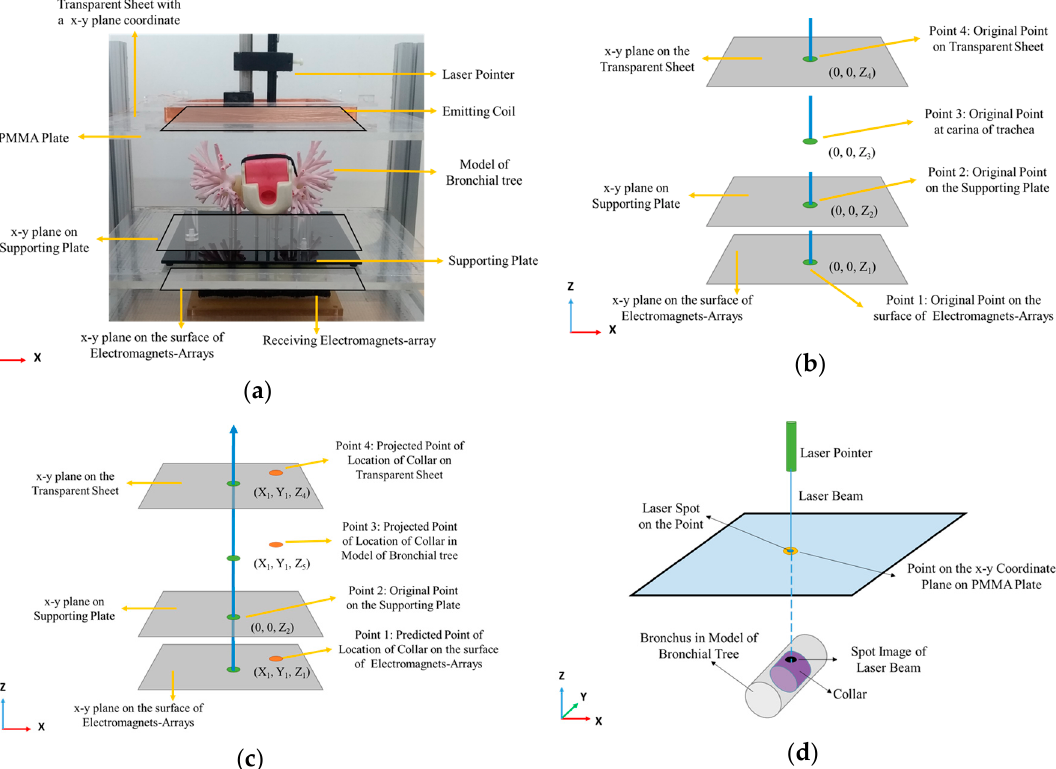
Figure 8. The photograph and illustration of the three parallel x – y planes and their coordinates for our targeting system: ( a ) the photograph shows each x – y plane on the (PMMA) plate, supporting plate, and surface of the electromagnets-array, ( b ) the illustration shows original point in each x – y plane and at carina of trachea, ( c ) the illustration shows predict point and projected point of location of collar on each plane, and ( d ) the illustration of the “projection” that is the method to determine a z -coordinate by using a laser pointer.